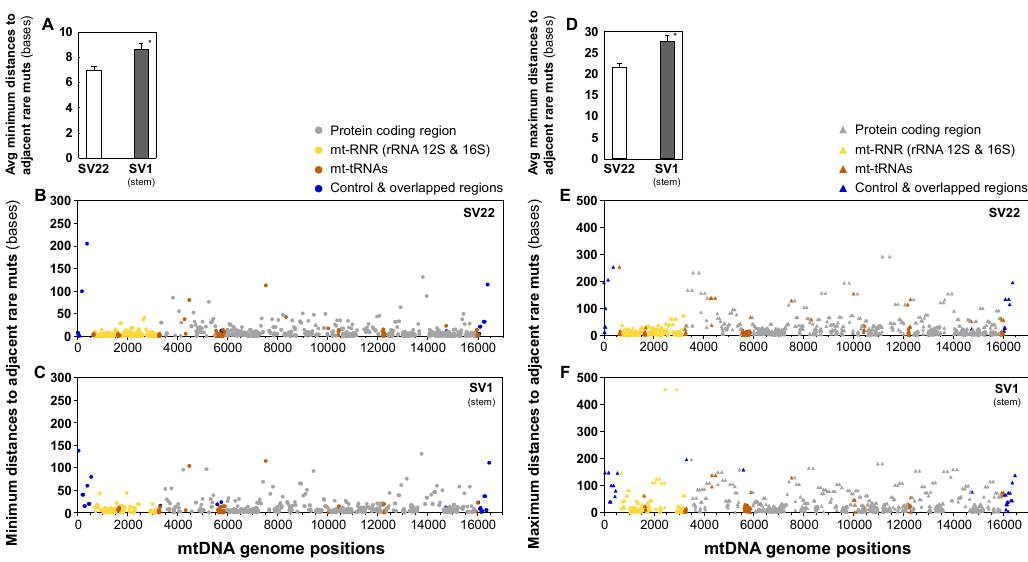
Figure 6. Genomic positions and average minimum and maximum distances to adjacent rare mutations (in bases) in the whole mtDNA. Minimum ( A – C ) and maximum ( D – F ) distances to adjacent rare mutations in both 5′ and 3′ directions were determined for each SV22 (immortalized non-stem) and SV1 (immortalized stem) rare mutations using Duplex Sequencing. Error bars represent standard error of the mean (SEM). Significant differences in average distances to adjacent rare mutations between two groups are indicated (* p < 0.001) by the Mann-Whitney Rank Sum Test.